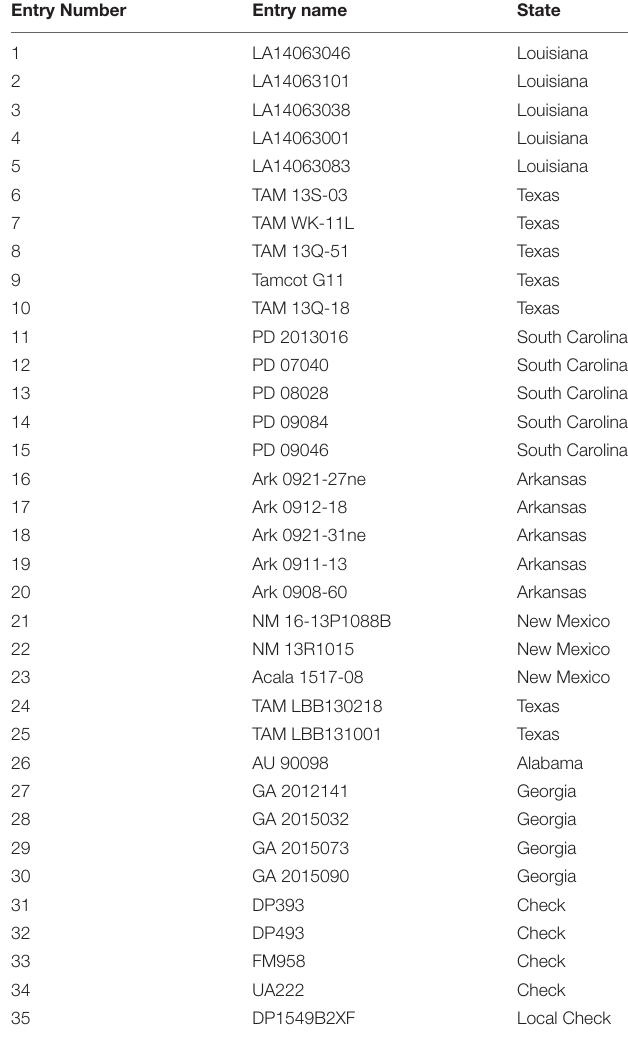
TABLE 1 | Cotton entries provided by the Regional Breeders Testing Network, listed by the program entry number with the corresponding breeding line name and originating